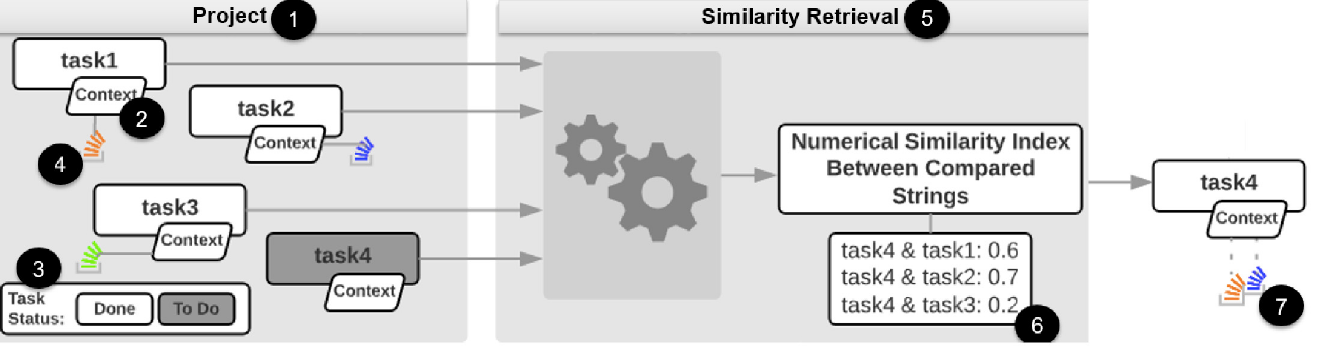
Fig 3. Proposed similarity approach